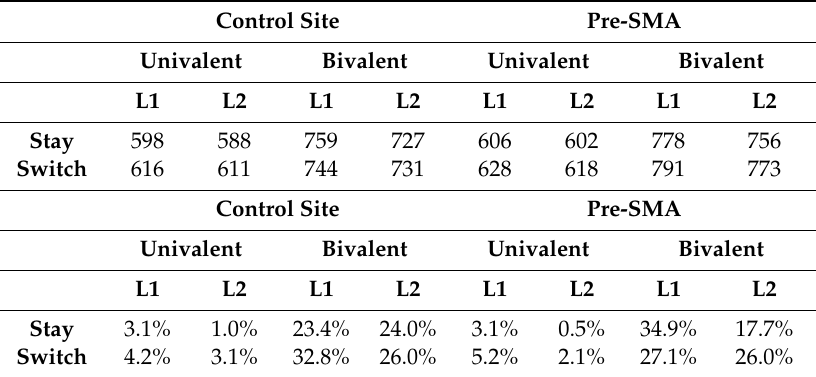
Table 4. Mean reaction times ( top ) and error rates ( bottom ) in each condition in Experiment 2: “location of transcranial magnetic stimulation (TMS)” (control site vs. pre-SMA) × “valence” (univalent